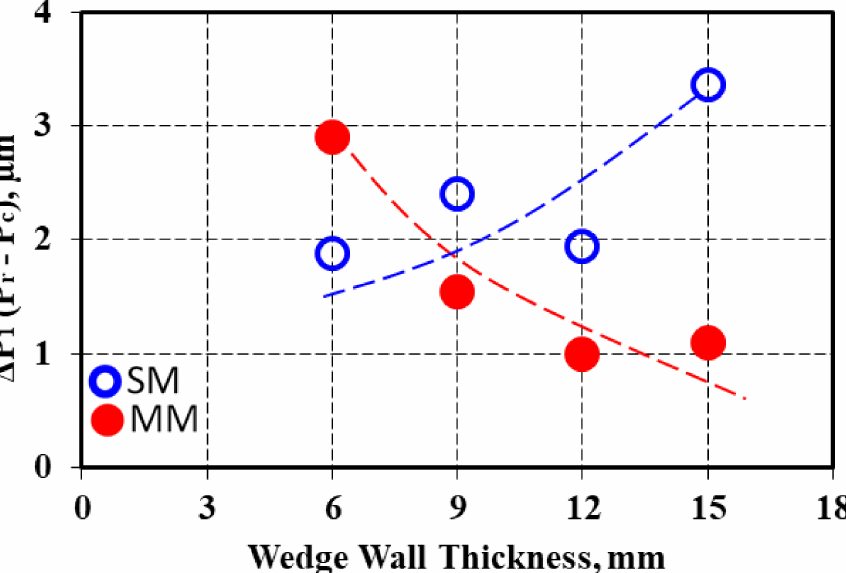
Figure 7. Influence of the wedge casting wall thickness on the difference between the real and convex perimeter ( ∆ P 1 ) for the sand and metal